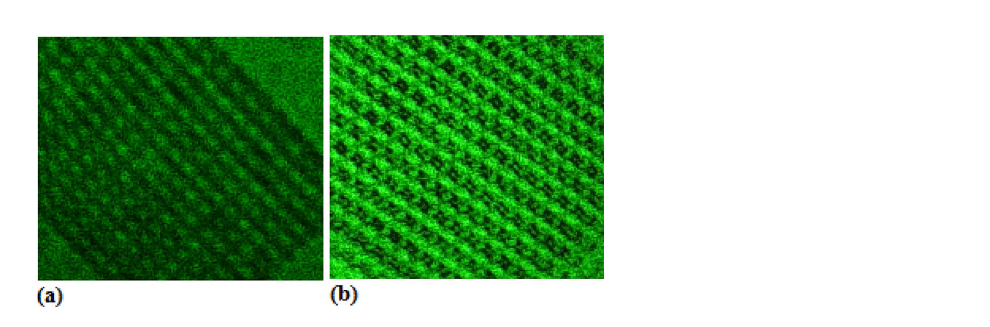
Figure 4. ( a ) Dark field image and ( b ) Bright field image, which appear at r 2 = r m and r 2 = r m + Δr respectively , where the Δr relates to the phase term [π(λn 2 R 1 r 2 )/(( R 1 + r 2 )d 2 )] = (2 N +